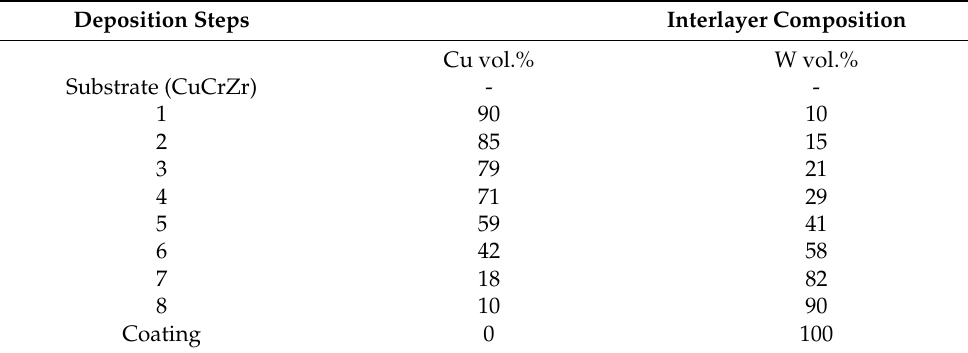
Table 1. Composition of the layers deposited in each step.